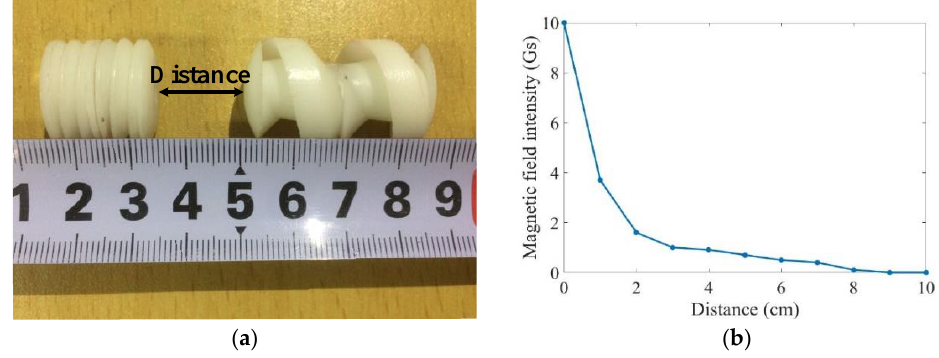
Figure 10. Magnetic field intensity generated by JPMs: ( a ) distance between two JPMs; ( b ) relationship between magnetic field intensity and distance.